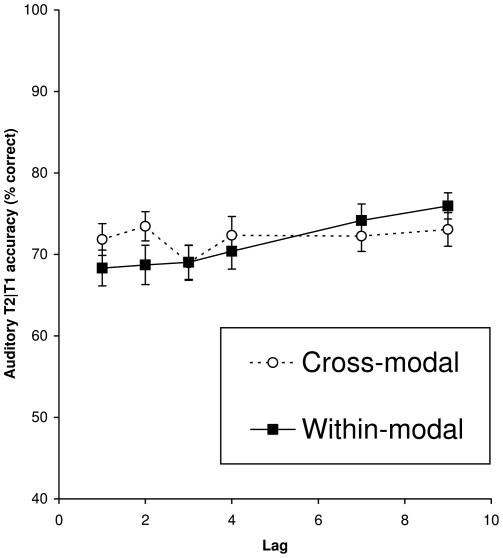
Auditory T2 accuracy.Mean percentage correct report of an auditory T2 given correct report of T1 as a function of lag when presented within (solid line) or between modalities (dotted line).